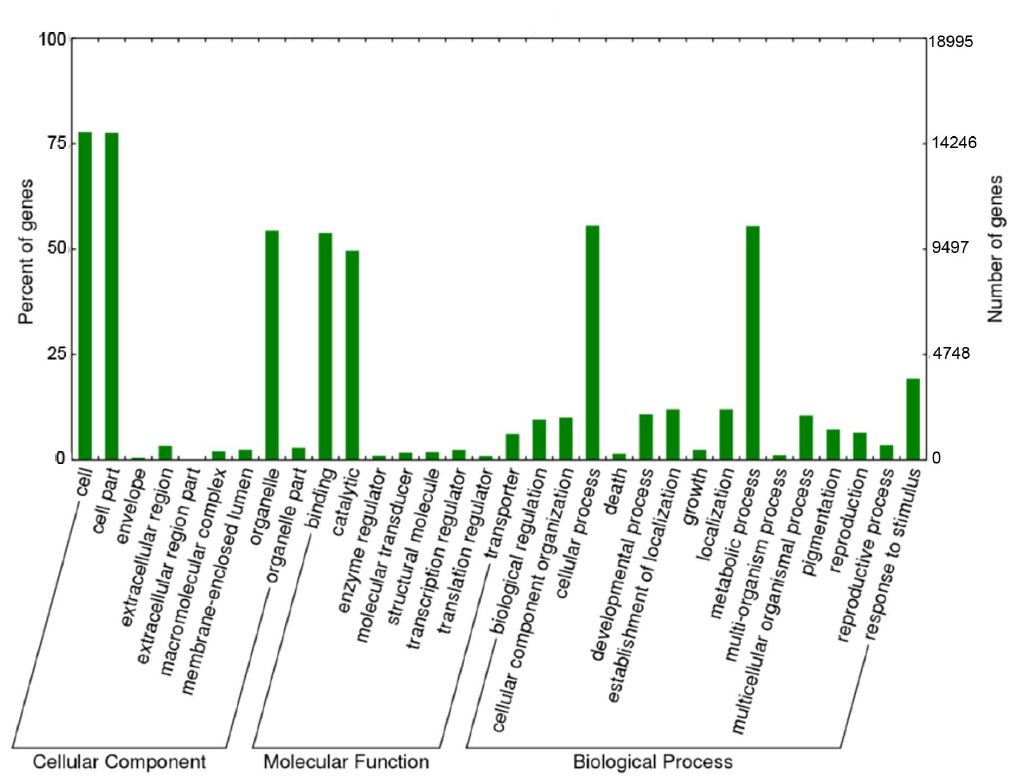
Figure 2. Gene ontology classification of Panicummaximum unigenes. Distribution of the GO categories assigned to the P. maximum transcriptome. Transcripts were classified into three categories: cellular components, molecular functions and biological processes.